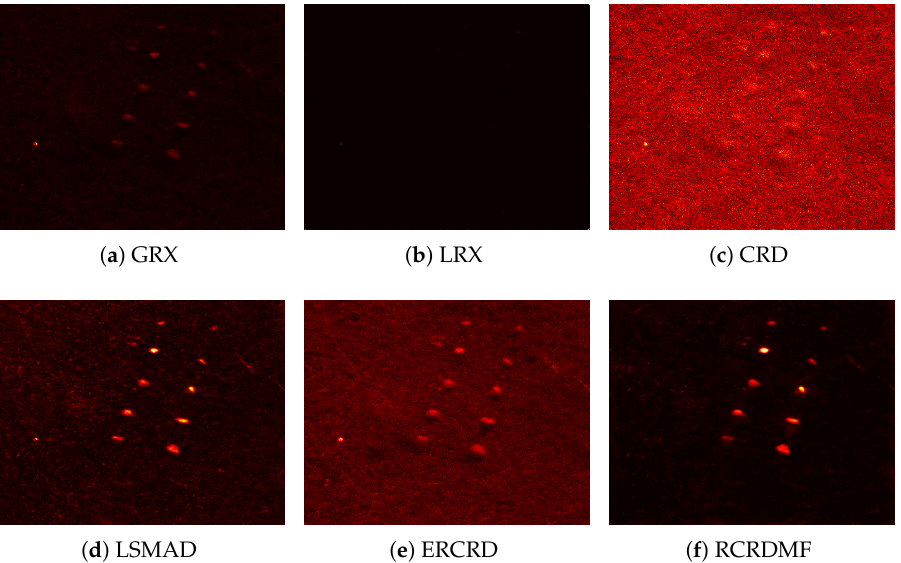
Figure 11. Color detection maps obtained by different algorithms for the Cri dataset. ( a ) GRX, ( b )